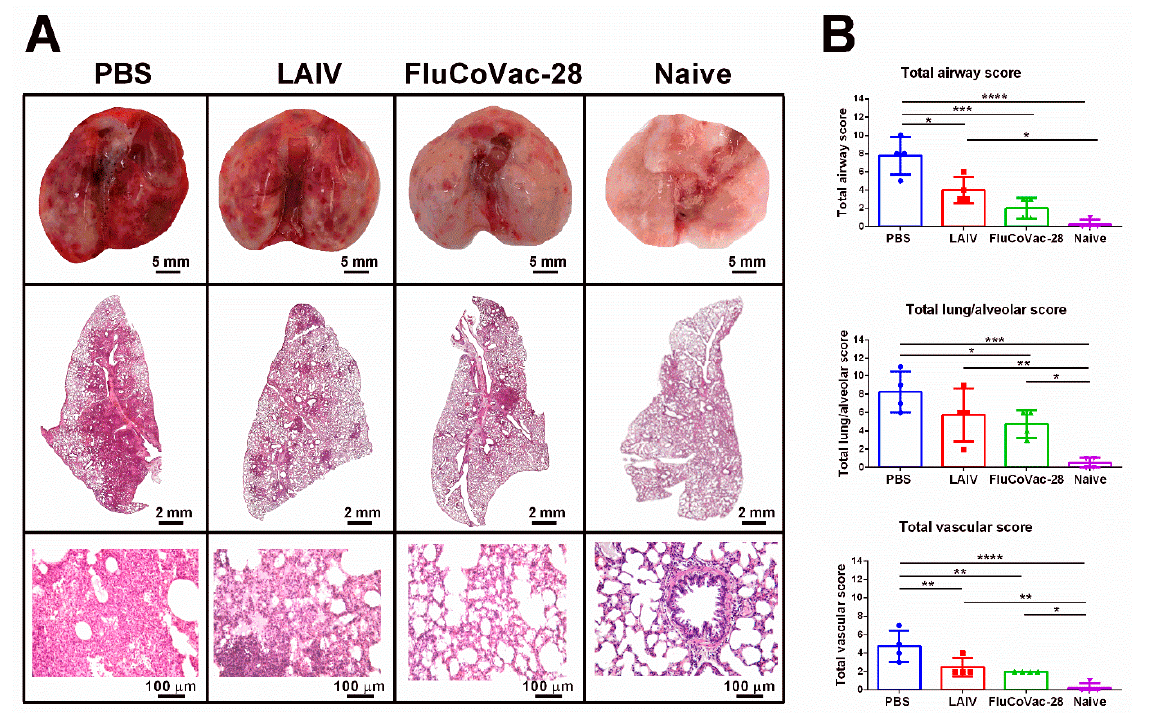
Figure 8. The histopathological evaluation of lung tissues of immunized Syrian hamsters on day 5 after challenge with SARS-CoV-2 Delta virus or naïve uninfected animals. ( A ) Representative micrographs of the lungs and lung sections stained with Hematoxylin & Eosin. ( B ) Semi-quantitative analyses of the changes in airway, lung/alveolar and vascular systems. Data were analyzed by one- way ANOVA with Tukey’s post-hoc multiple analyses test. *— p < 0.05; **— p < 0.01; *** — p < 0.001; ****— p < 0.0001.